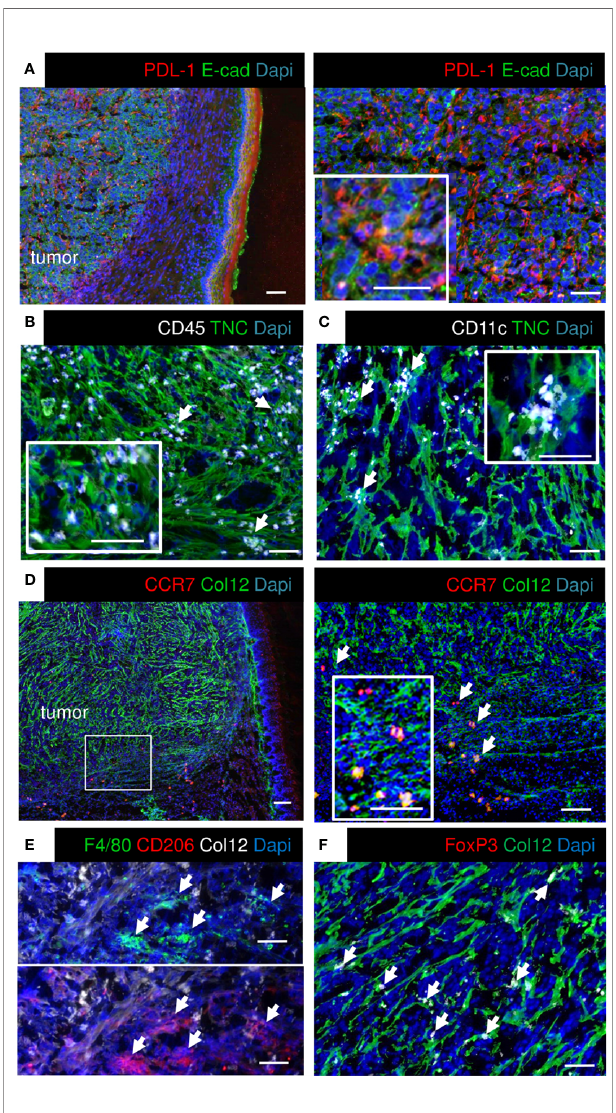
FIGURE 3 | Characterization of immunity markers in OSCC13 tumors by immunostaining. About 4 weeks syngeneic tongue tumors derived from 1 × 10 6 engrafted OSCC13 cells were stained for the indicated molecules. Representative images are shown (N = 3). Scale bar, 100 µm. Arrows point at CD45+ (B) , CD11c+ (C) , CCR7+ (D) , F4/80 and CD206+ (E) and Foxp3+ cells (F) that are in close vicinity to matrix. (A, D) , scale bar, 500 m m (left). Right panels, higher magni fi cation. Scale bar, 50 m m (A) , 100 m m (D)